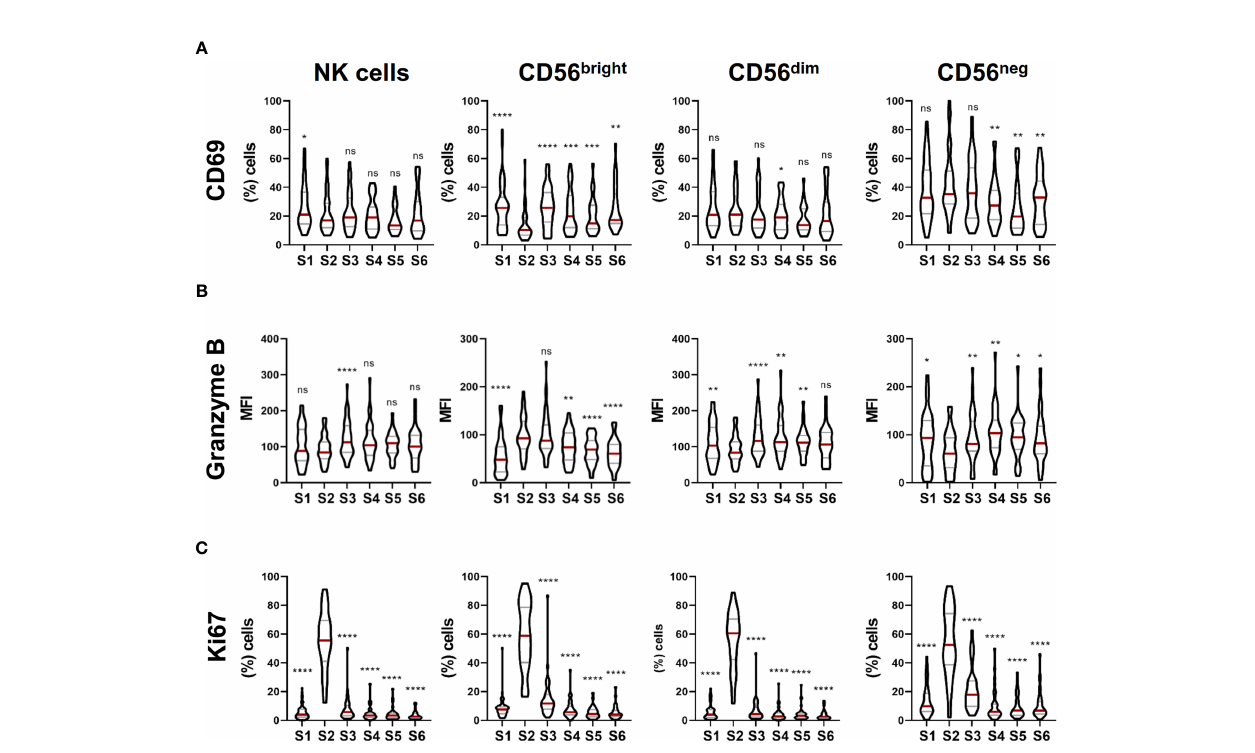
FIGURE 3 | NK cell activation, cytotoxic potential and proliferation capacity are modulated during NK cell reconstitution after autoHSCT. (A) Violin plots showing the percentage of CD69+ cells within total NK cells and CD56 bright , CD56 dim and CD56 neg NK cell subsets at the six studied time points (S1-S6) (S1 n=46; S2 n=37; S3 n=37; S4 n=35; S5 n=29; S6 n=29). (B) Violin plots showing the median fl uorescence intensity (MFI) of granzyme B within total NK cells and CD56 bright , CD56 dim and CD56 neg NK cell subsets (S1 n=54; S2 n=43; S3 n=44; S4 n=43; S5 n=35; S6 n=36). (C) Violin plots showing the percentage of Ki67+ cells within total NK cells and CD56 bright , CD56 dim and CD56 neg NK cell subsets (S1 n=54; S2 n=43; S3 n=44; S4 n=43; S5 n=35; S6 n=36). Violin plots show the median and the quartiles. Signi fi cance of data was determined by comparing each sample with sample S2. *p < 0.05, **p < 0.01, ***p < 0.001, ****p < 0.0001 and ns, no signi fi cant (t test for paired values or Wilcoxon matched-pairs signed rank